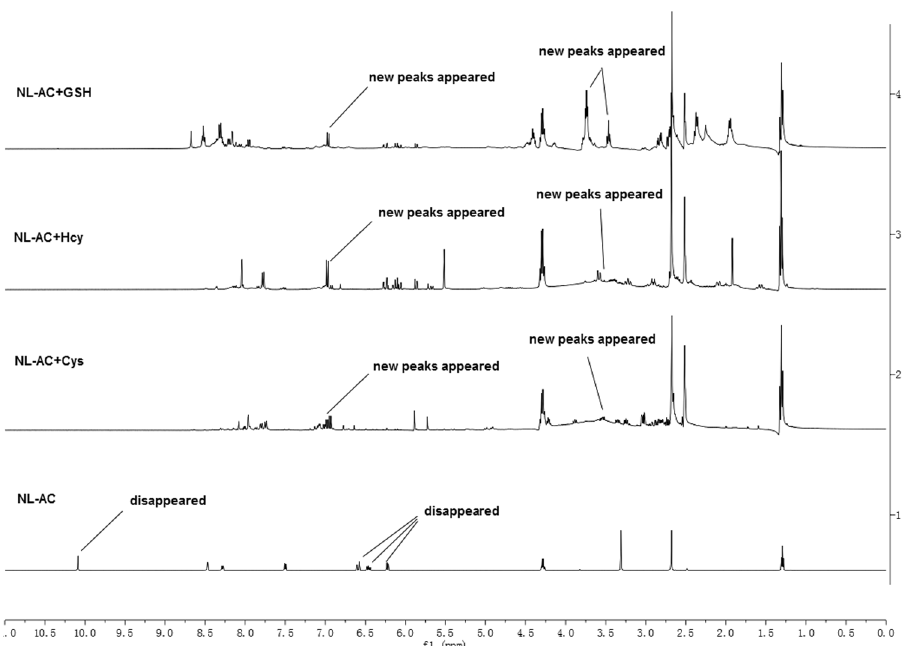
Figure 5. 1 H NMR spectrum of NL-AC in d 6 -DMSO and the resulting spectrum after the addition of Cys, Hcy or